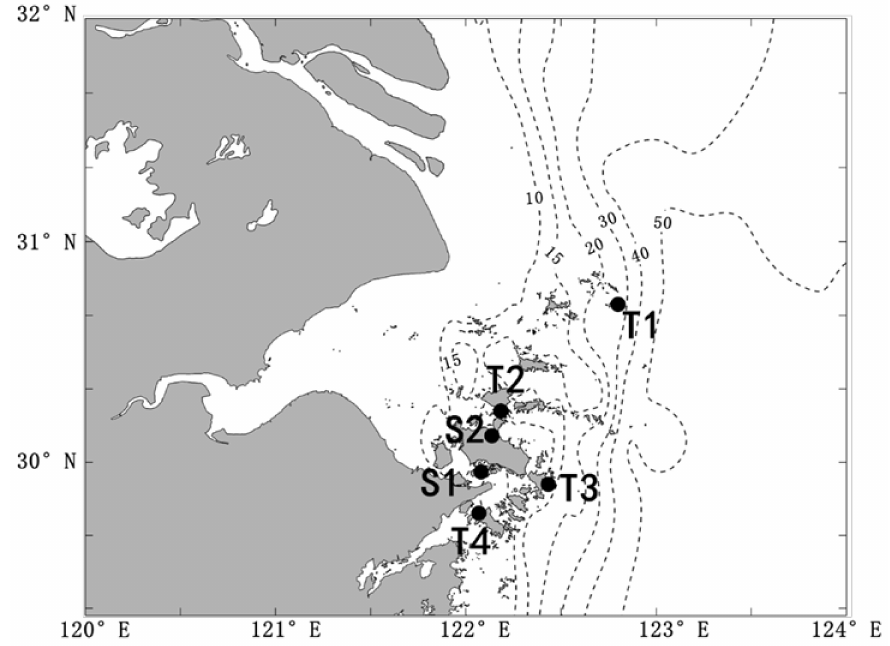
Figure 1. Model domain, topography, and observational sites (S1–S2,